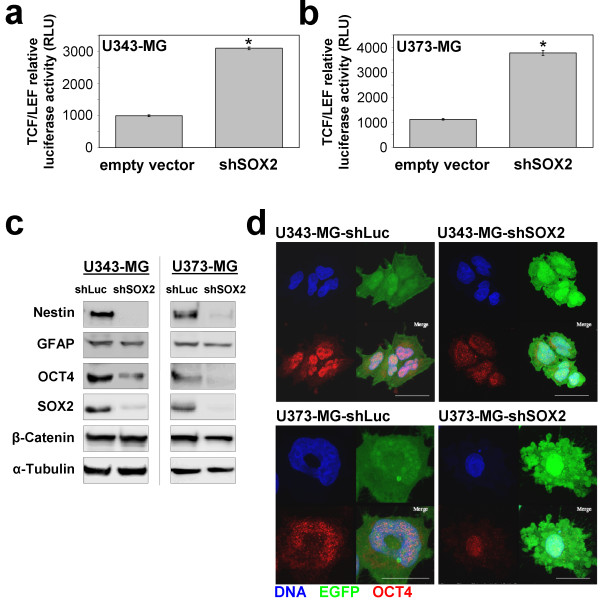
SOX2-RNAi increases TCF/LEF-signaling and decreases Nestin and OCT4 steady state protein expression levels. a: U343-MG and b: U373-MG glioma cells stably expressing TCF/LEF-driven luciferase were transduced with sh2378 or empty vector and analyzed. Note the increase in luciferase activity after knockdown of SOX2 in both glioma cell lines. Bars indicate standard deviation. * p < 0.05 when SOX2-silenced cell were compared to controls. c: Western blot analysis for stem cell markers Nestin and Oct4 in U343-MG and U373-MG cells with knockdown of SOX2 showing loss of protein expression when compared to shLuc controls. Steady state protein expression levels of astrocyte marker glial fibrillary acidic protein (GFAP) and β-Catenin remained unchanged. Equal loading of lanes was confirmed using tubulin antibodies. d: Indirect immunofluorescence showing decrease of Oct4 immunosignals in U343-MG and U373-MG cells treated with sh2378 when compared to shLuc controls. Magnification bars: 20 μm.